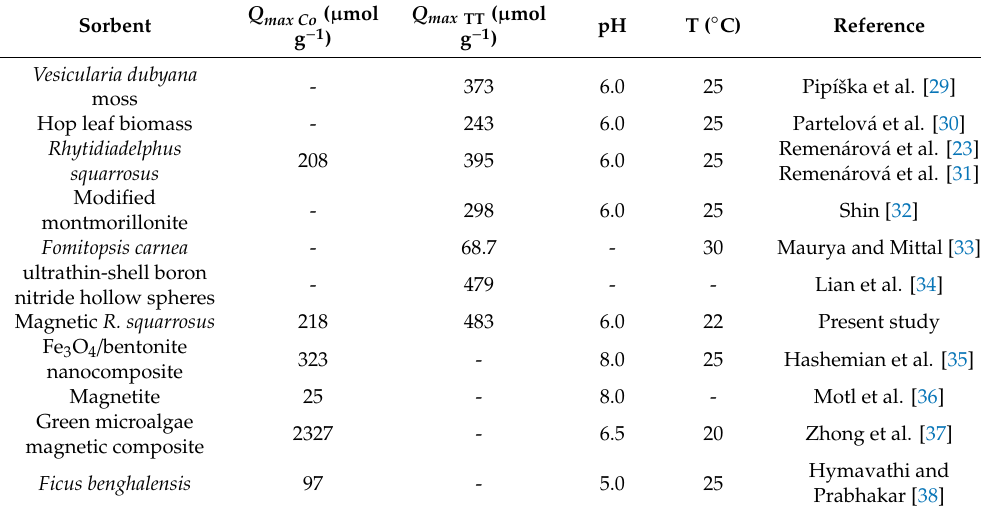
Table 3. The maximal adsorption capacities Q max of for Co 2 + and TT by di ff erent sorbents determined from the Langmuir